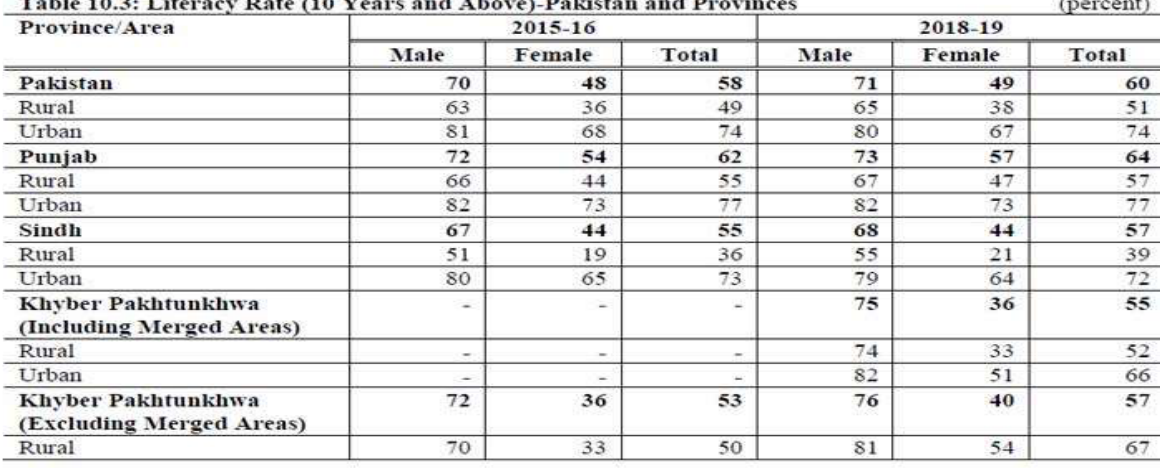
Table 3. Literacy Rate in Percent (10 years and above) – Pakistan and Provinces